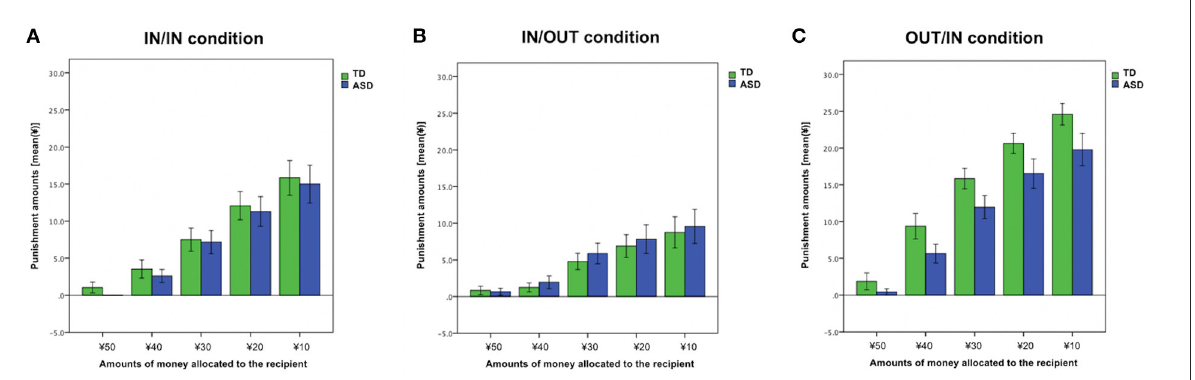
FIGURE4 Punishment amount across each trial. (A) IN/IN (both the proposer and recipient were ingroup members) condition. (B) IN/OUT (the proposer was an ingroup member, whereas the recipient was an outgroup member) condition. (C) OUT/IN (the proposer was an outgroup member, whereas the recipient was an ingroup member) condition. Error bars indicate ± standard